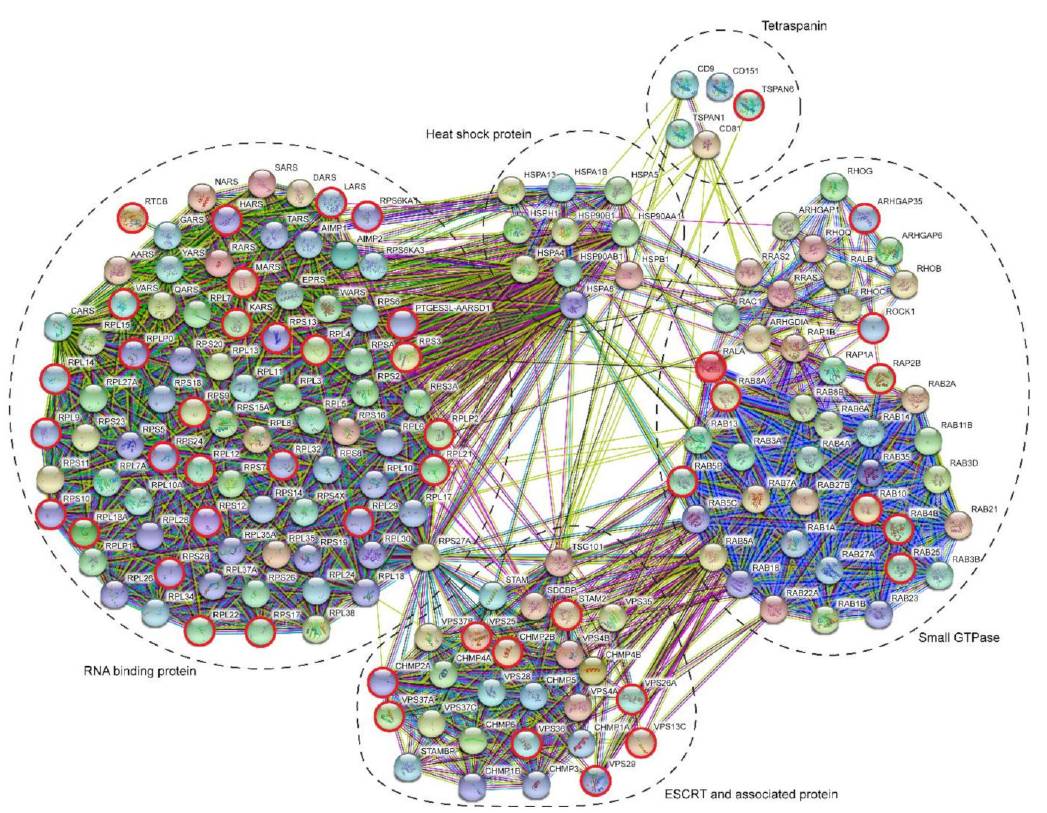
Figure 6. Protein–protein interaction network as determined by STRING for all proteins shown in Figure 5. Red encircled proteins were detected in LEV only. All other proteins were detected in both LEV and SEV. Dotted lines indicate the di ff erent protein groups in Figure 5A–E. Note that these protein groups are maintained by this presentation. Additionally, note the linkage between “RNA binding proteins” and “ESCRT and associated proteins” by RPS27A, and that both “tetraspanins” and “small GTPases” are linked to “RNA binding proteins” via “heat shock